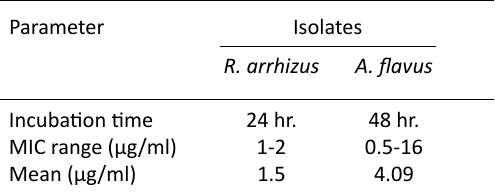
Table 3. In vitro susceptibilities of fungal isolates to Amphotericin B as determined by CLSI M38-A broth dilution